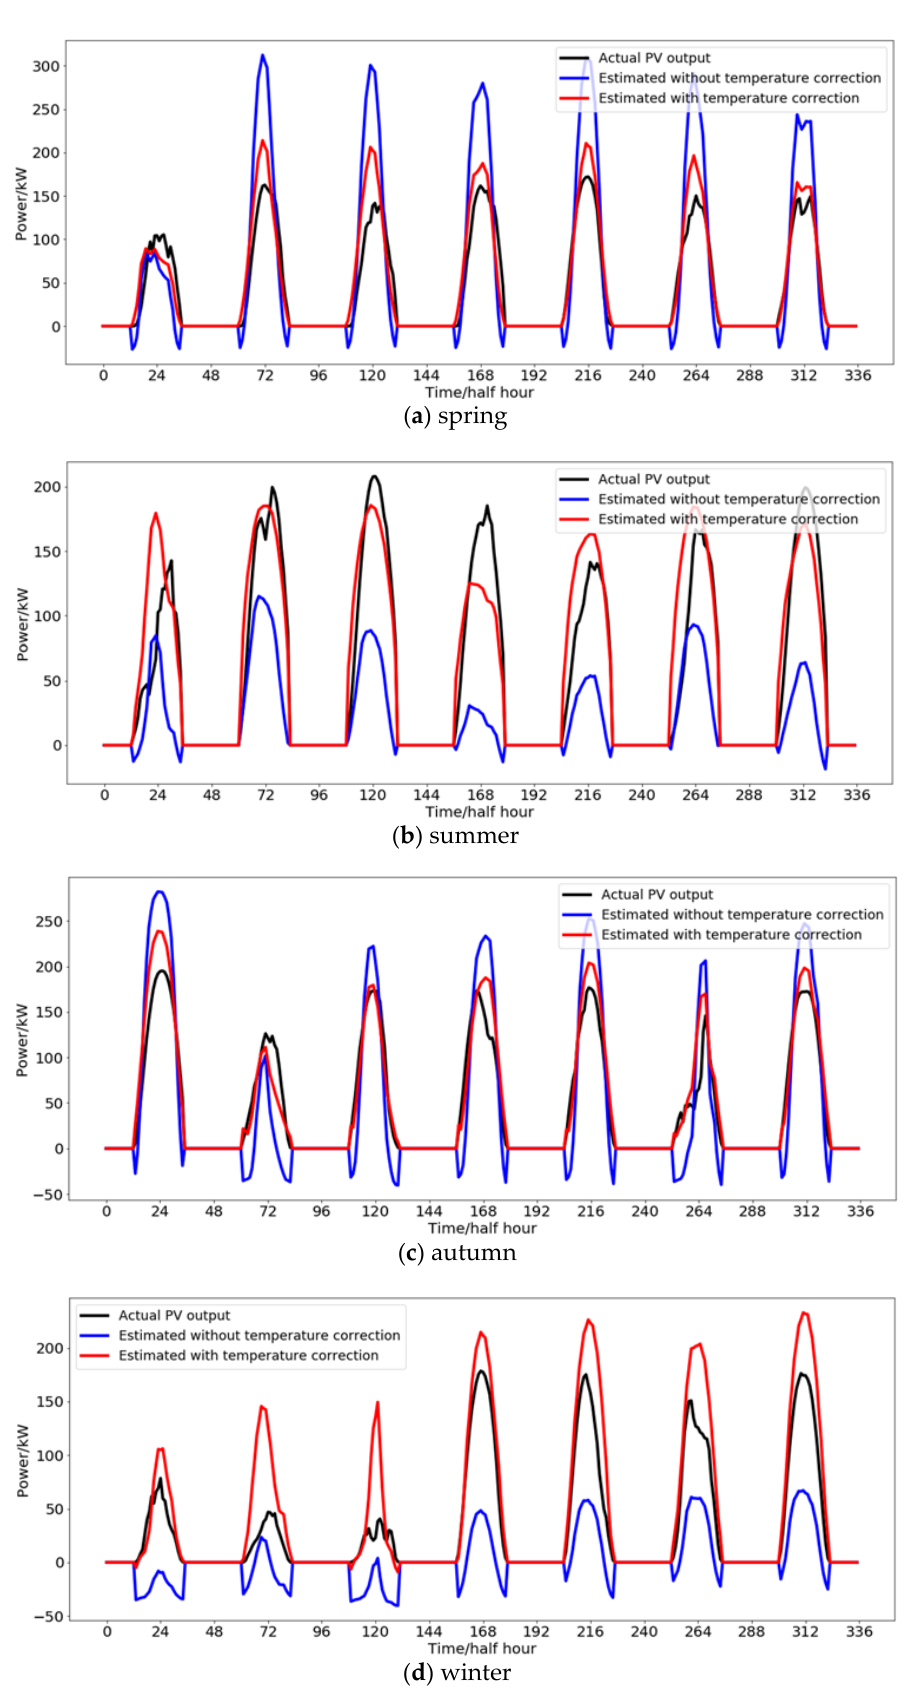
Figure 6. Estimated PV output power curves for a week.